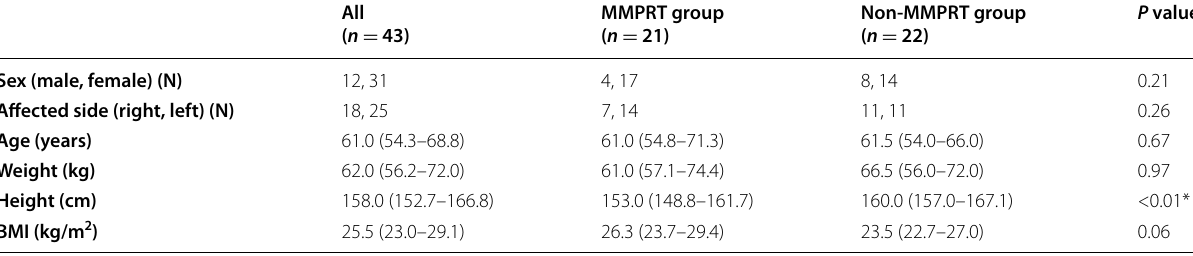
Table 1 Comparison of the patient characteristics between the MMPRT and non-MMPRT